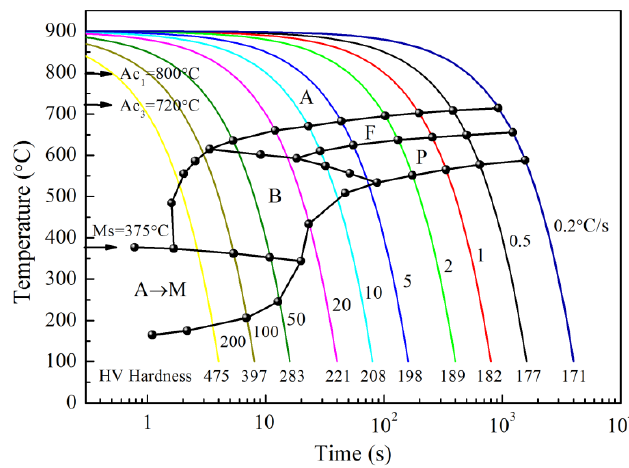
Figure 5. Continuous Cooling Transformation (CCT) diagram of J55 steel.